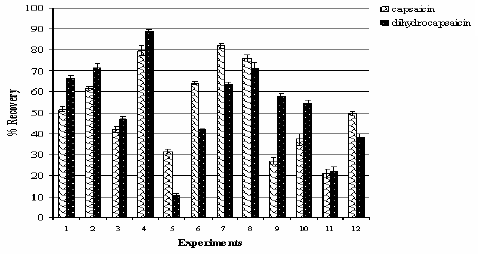
Figure 4. Recovery (%) of capsaicinoids from 12 experimental trials (mean  SD, n = 3).